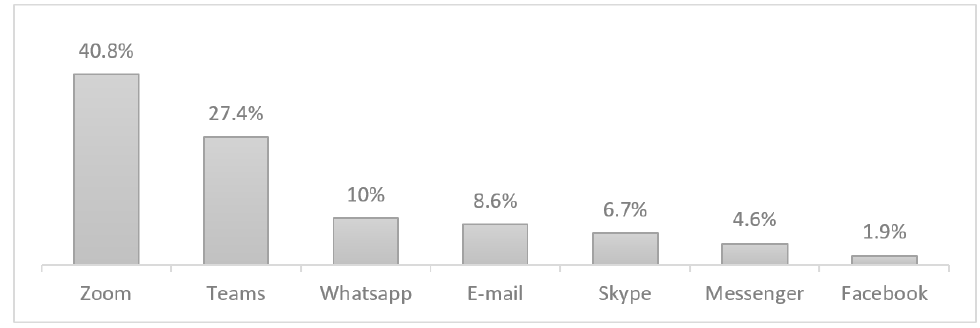
Figure 2. New ICT tools.